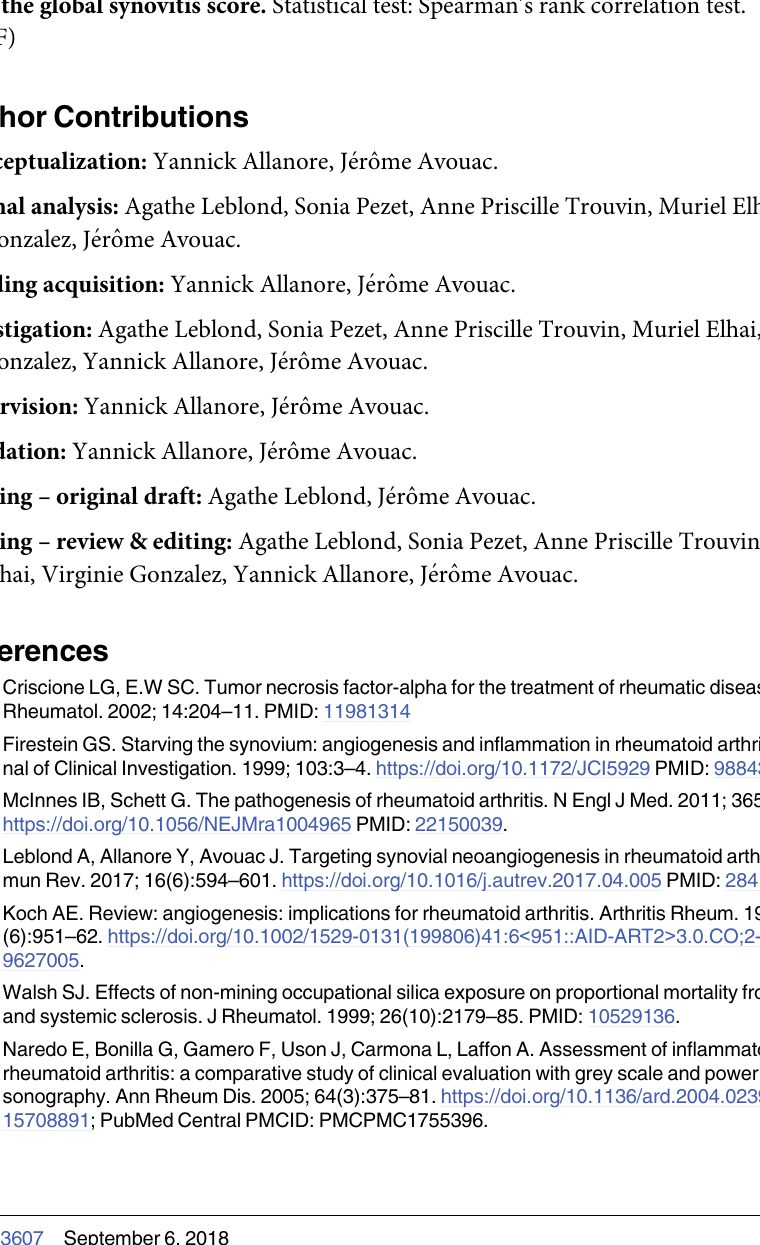
S1 Table. Biological function, intra-assay and inter-assay coefficients of variation, recovery and linearity of each angiogenic marker. S2 Table. Levels of angiogenic markers in RA patients. S3 Table. Correlation between angiogenic markers in RA patients. S1 Fig. Correlations between serum levels of sVAM-1 (A), Tie2 (B) and Angiostatin (C) with the global synovitis score. Statistical test: Spearman’s rank correlation